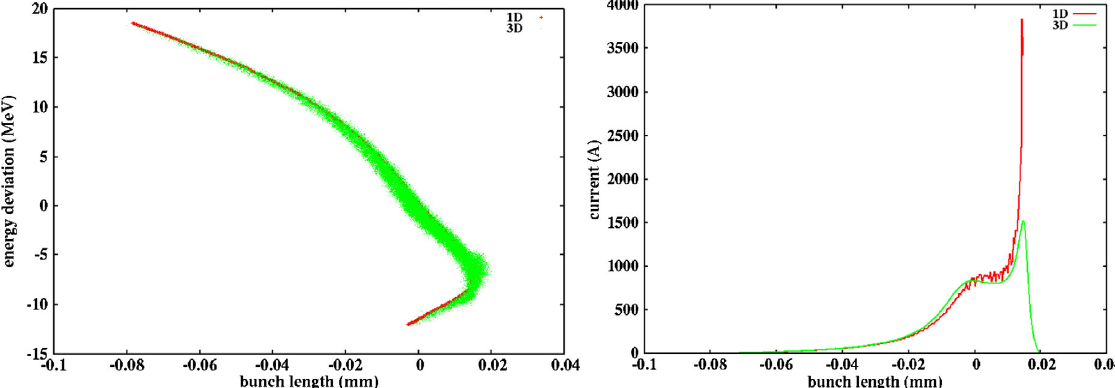
FIG. 4. Longitudinal phase space distribution (left) and current profile (right) after BC2 of the linac from the 1D model (red) and from the 3D model (green).